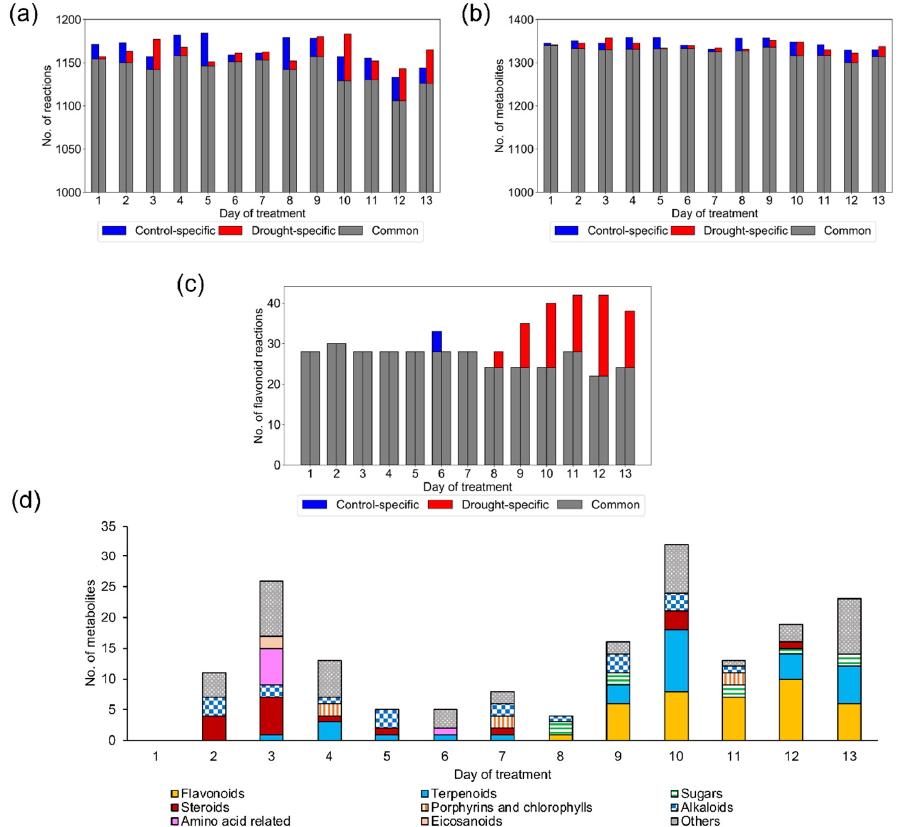
Figure 2. Features of context-specific GEMs: ( a ) Total number of reactions in each GEM, ( b ) total number of metabolites in each GEM, and ( c ) number of reactions in the “flavonoid biosynthesis” subsystem in each GEM. In Figure 2a–c, the left and right bars in a day represent the number in control and drought GEMs, respectively. The control-specific, drought-specific, and common reactions are displayed in blue, red, and grey, respectively. ( d ) Number of metabolites present only in drought GEMs: Metabolites are categorized based on KEGG BRITE database (Kyoto encyclopedia of genes and genomes - functional hierarchies of biological entities: https: // www.genome.jp / kegg / brite.html) and shown in di ff erent